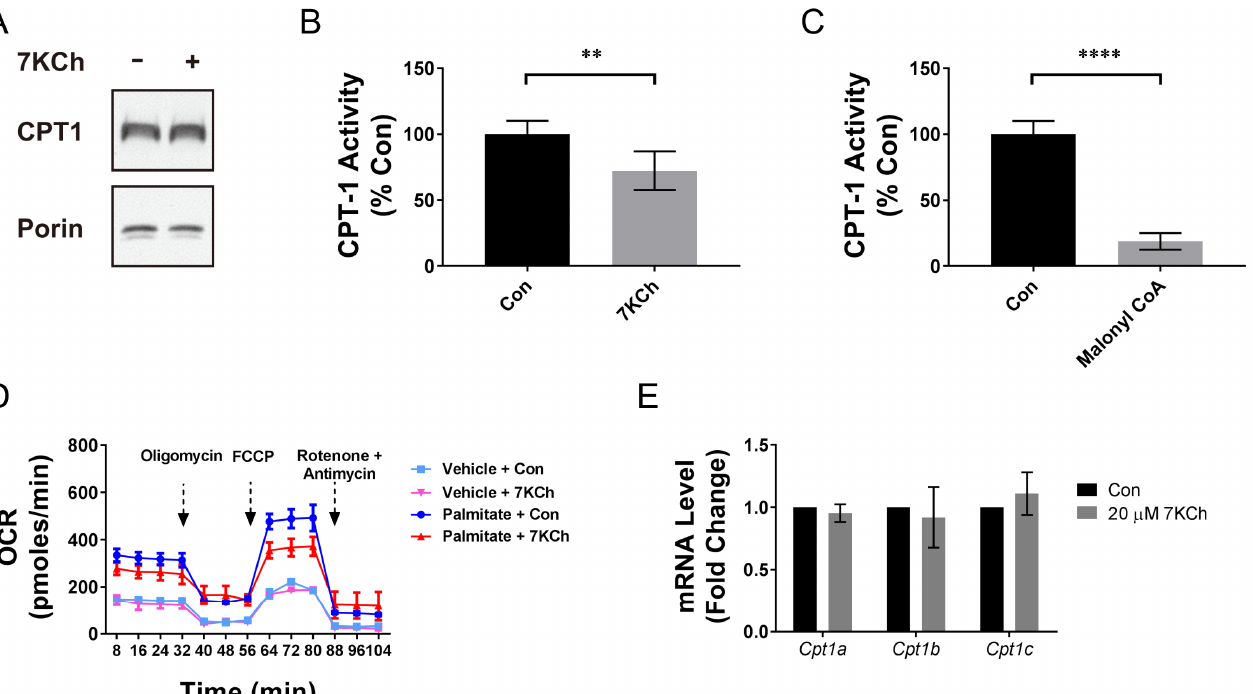
Figure 5. CPT-1 activity and β -oxidation in cardiomyocytes are inhibited by 7KCh. ( A , B ) The HL-1 cells were treated with the vehicle (Con) or 20 µ M 7KCh for 24 h, and a crude mitochondrial fraction was prepared for the analysis of CPT-1 and porin expression by immunoblotting ( A ) and for the measurement of CPT-1 activity ( B ). For immunoblotting ( A ), a representative of three experiments is shown. ( B ) The CPT-1 activity of the 7KCh-treated cells is expressed as the percentage of that of untreated control cells. Data are mean ± SD, N = 6. ** p < 0.01 vs. the untreated control cells. ( C ) The crude mitochondrial fraction of the HL-1 cells was treated with the vehicle (Con) or 5 µ M malonyl-CoA and assayed for the CPT-1 activity. Data are mean ± SD, N = 6. The CPT-1 activity of the malonyl-CoA treatment group is expressed as the percentage of that of Con group. **** p < 0.005 vs. the Con group. ( D ) The HL-1 cells were treated with the vehicle (Con) or 20 µ M 7KCh for 24 h and were subjected to fatty acid oxidation assay using palmitate-BSA as a substrate (or BSA as the vehicle control for palmitate treatment; vehicle). A representative of three experiments is shown. ( E ) The cells were similarly treated, and the total RNA was extracted for the qRT-PCR-based quantification of Cpt1a , Cpt1b , and Cpt1c expression. Data are mean ± SD, N = 3.